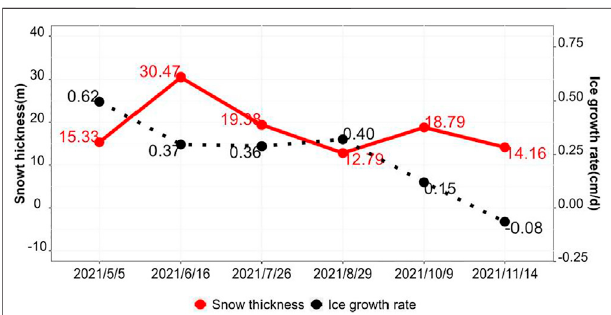
Figure 4 . Before October 9, frequent and large fl uctuations in the